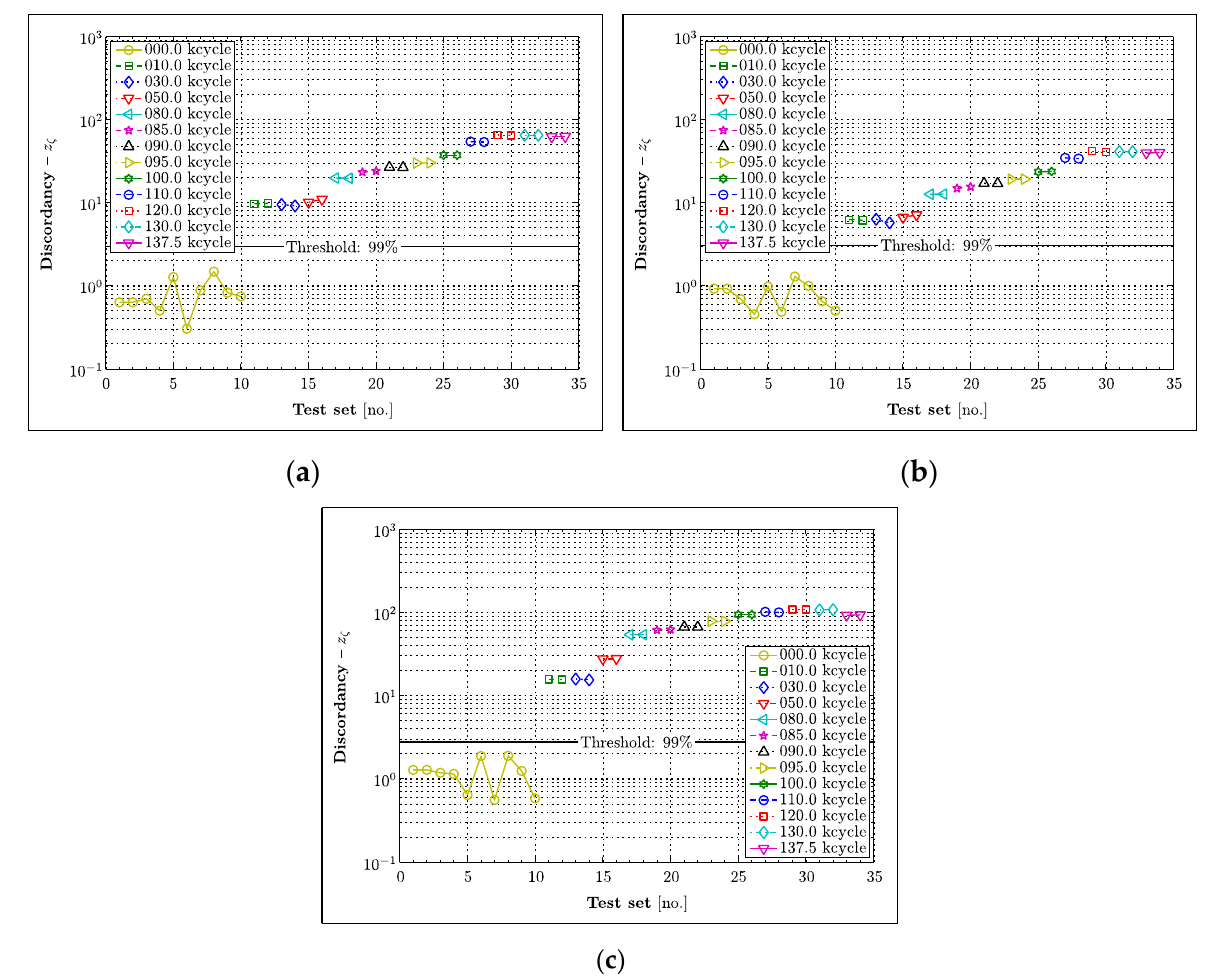
Figure 11. Univariate outlier analysis for analysed damaged indices based on: ( a ) peak-to-peak value; ( b ) maximum of envelope function; ( c ) integrated envelope function.